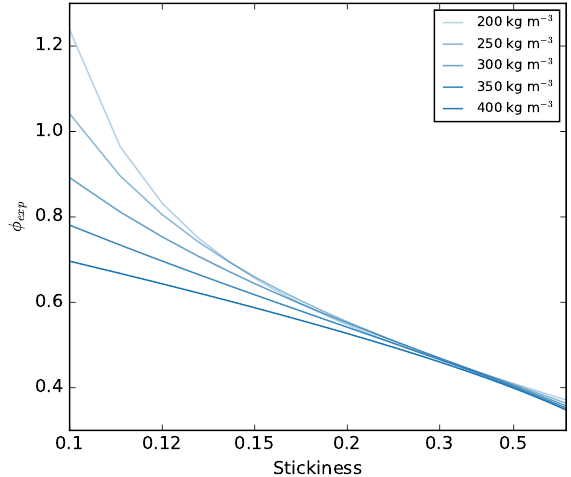
Figure 8. Scaling factor φ exp needed for simulations with ex- ponential autocorrelation function with scaled correlation length ( 1 − ρ/ρ ice )a to yield the same brightness temperature at φ exp 4 3 V polarization as simulations with sticky hard spheres with a ra- dius a = 100µm. Other parameters are similar to Fig.